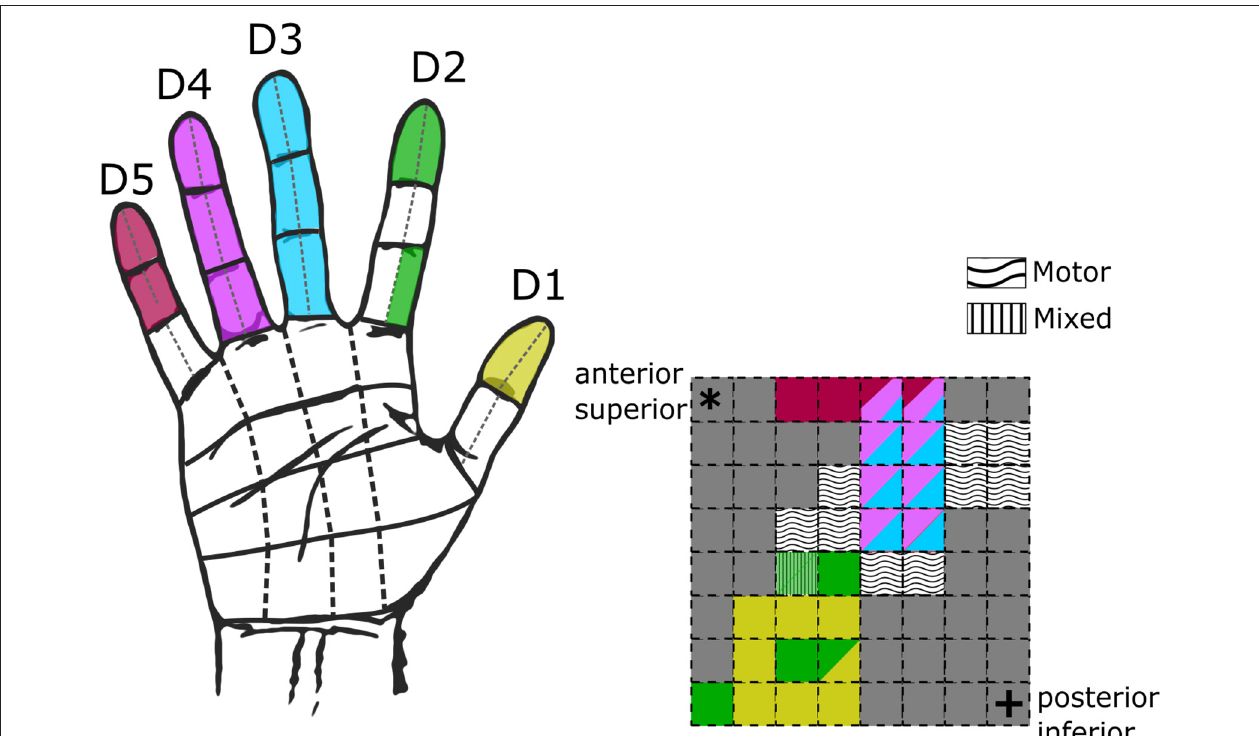
FIGURE 3 | Hand receptive fields from grid mapping in a single subject. Schematic of hand coverage from initial grid mapping with subject S08 at 50 Hz, 500 µ s, 2–4 mA. On the left, a hand diagram with the overlaid color-coded receptive fields from all tested electrodes. On the right, a schematic of the mini-ECoG grid following the same color code displayed on the hand to display in which digits the subject reported the sensations. Multiple colors in a single electrode indicate sensations across multiple digits. Wavy and stripped textures illustrate electrodes which elicited motor-only and mixed (motor-sensory) responses. Corner asterisk and cross markers on the grid indicate the anatomical orientation of the implanted